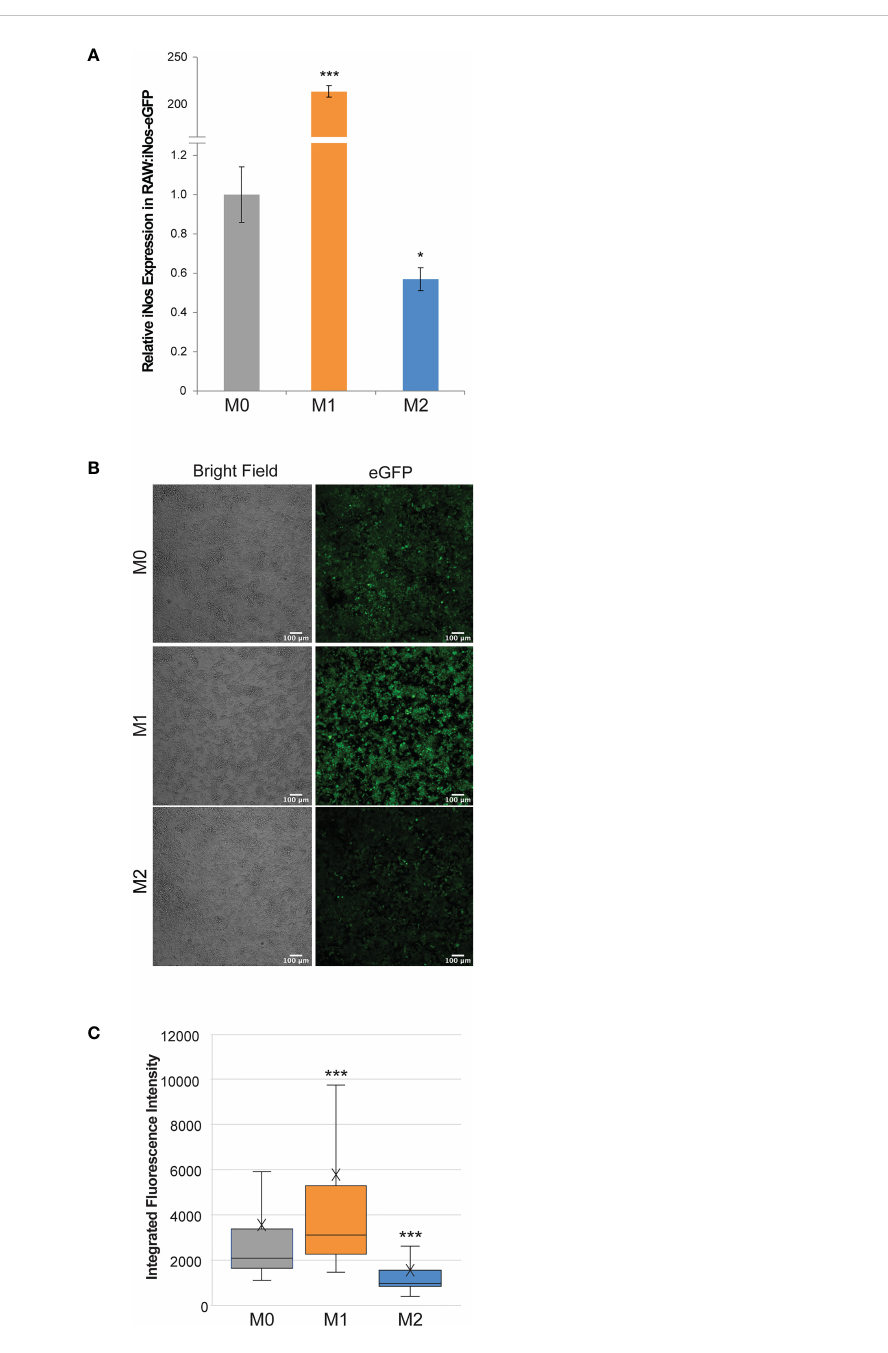
macrophages toward a pro-in fl ammatory, anti-tumor, M1 phenotype. While the change observed was not statistically signi fi cant, it is important to note that the mean values for 4T1 SCC (+) and EMT6 SCC (+) groups increased relative to the N.T. (-)